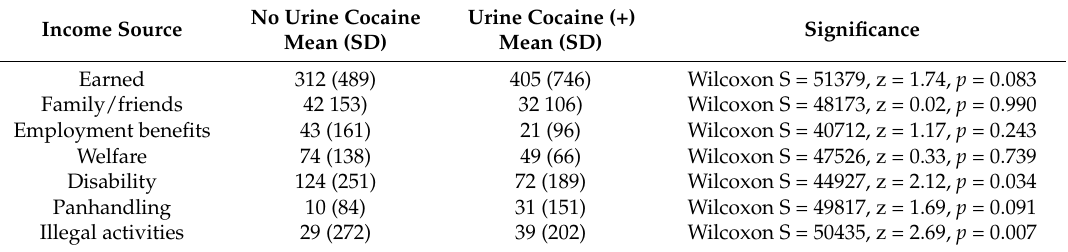
Table 4. Amounts earned from various 30-day income sources among those with and without a positive urine cocaine test in the same month.